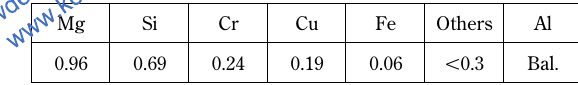
Table 1 Chemical composition of the as-received PM 6061.